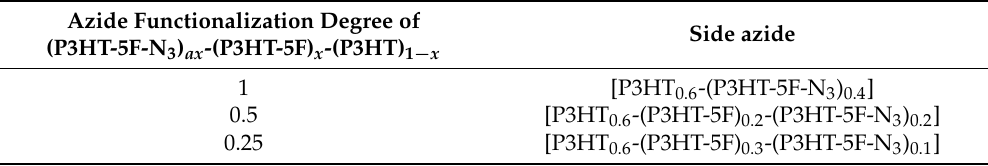
Table 1. Azidation ratios of [P3HT 0.6 -(P3HT-5F) 0.4 ] and the respective abbreviations of the functionalized polymers obtained.